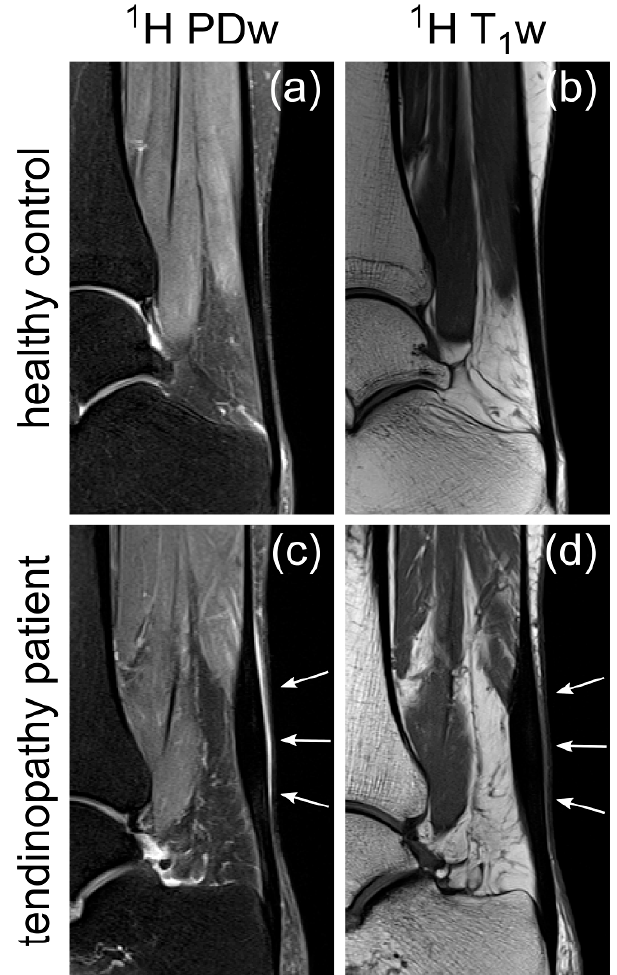
Figure 4. Sagittal proton density (PD) ( a , c ) and T 1 ( b , d ) weighted images of an exemplary healthy control ( a , b ) and the patient with Achilles tendinopathy ( c , d ) acquired as anatomical reference in line with clinical standard procedures. The patient showed local thickening mainly in the middle part of the AT with adjacent peritendinous fluid in the same region, which is both highlighted in ( c , d ) with white arrows.